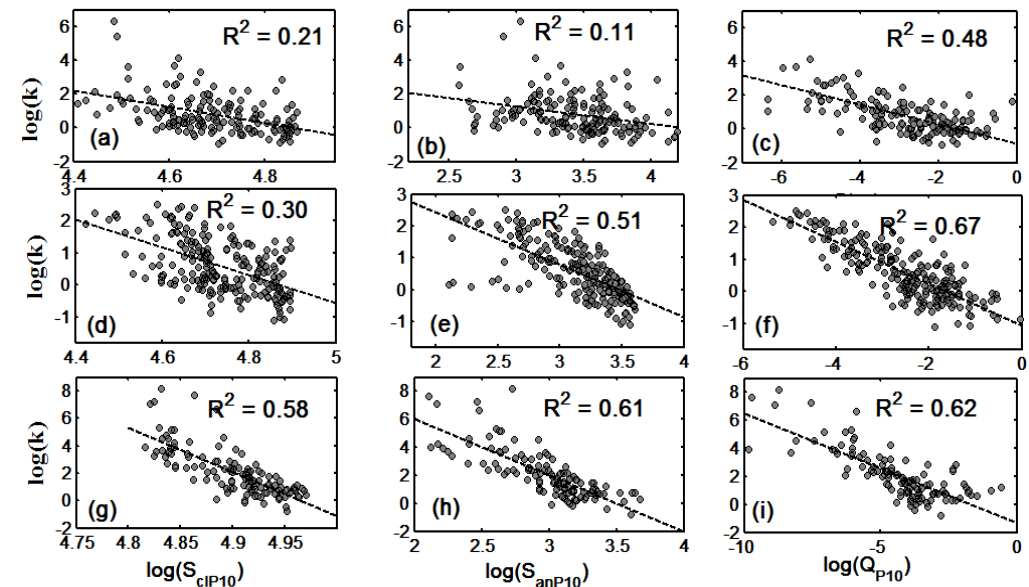
Figure 5. Plots giving a comparative view of S anPN , Q PN , and S clPN in terms of their ability (R 2 ) to explain variation of k for three sample basins: 07261500 ( a – c ), 03179000 ( d – f ), and 08153500 ( g – i ). Note that all the plots were obtained for N = 10. For each sample basin, R 2 was found to be greater than R 2 but less than R 2 , suggesting that although S anPN data is capable of explaining storage dynamics, it is associated with significant observational errors for smaller basin.